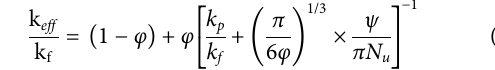
Frontiers in Energy Research |